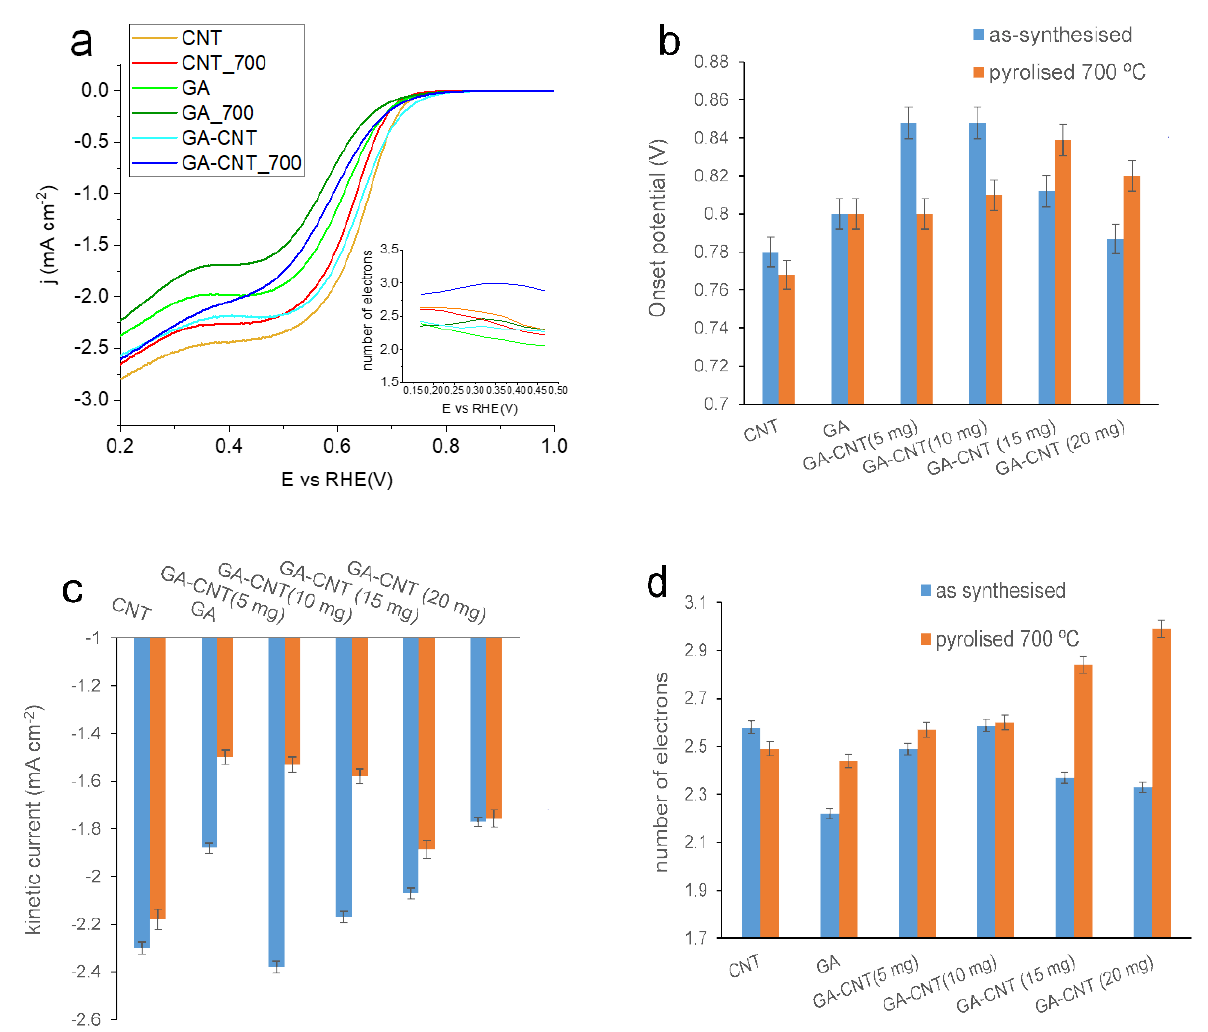
Figure 1. ( a ) LSV polarization curves and number of electrons exchanged (inset) for the CNT, GA, and the hybrid (GA-CNT) with 20 mg CNT as synthesised and after pyrolysis at 700 ◦ C. Electrochemical parameters for different carbon materials graphene aerogel (GA), carbon nanotubes (CNT), and their hybrids with different amounts of CNT before and after pyrolysing at 700 ◦ C. ( b ) Onset potential of LSV polarization curves in O 2 saturated 0.10 M KOH solution with a rotating rate of 1600 rpm; ( c ) kinetic current; and ( d ) number of electrons calculated from the slope of the K–L plots in a potential range of − 0.3 to − 0.5 V. Table 1. Elemental analysis of different materials.